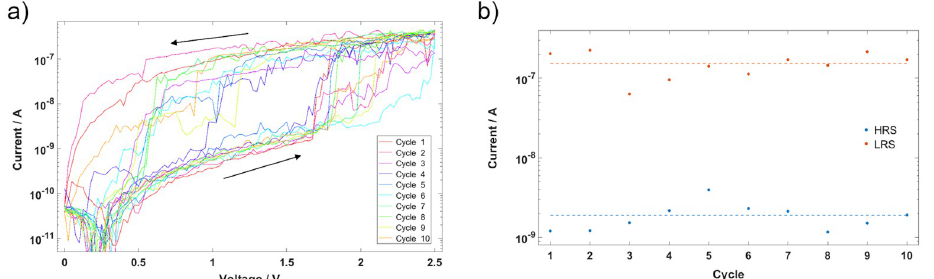
Fig 4. Resistive switching behaviour. a) Cyclic voltage pattern, showing resistive switching behaviour and an ON/ OFF ratio of around 81 at a Read voltage of 1.5 V. b) HRS and LRS currents at Read voltage of 1.5 V for each cycle.